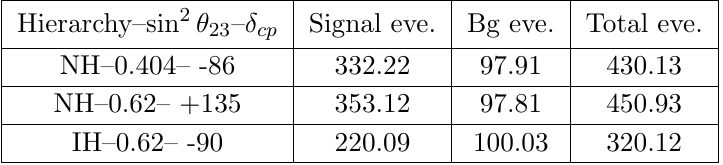
Table 6 . Number of expected (cid:23) e appearance events for one year (cid:23) run of DUNE, for the three solutions in ref. [32].